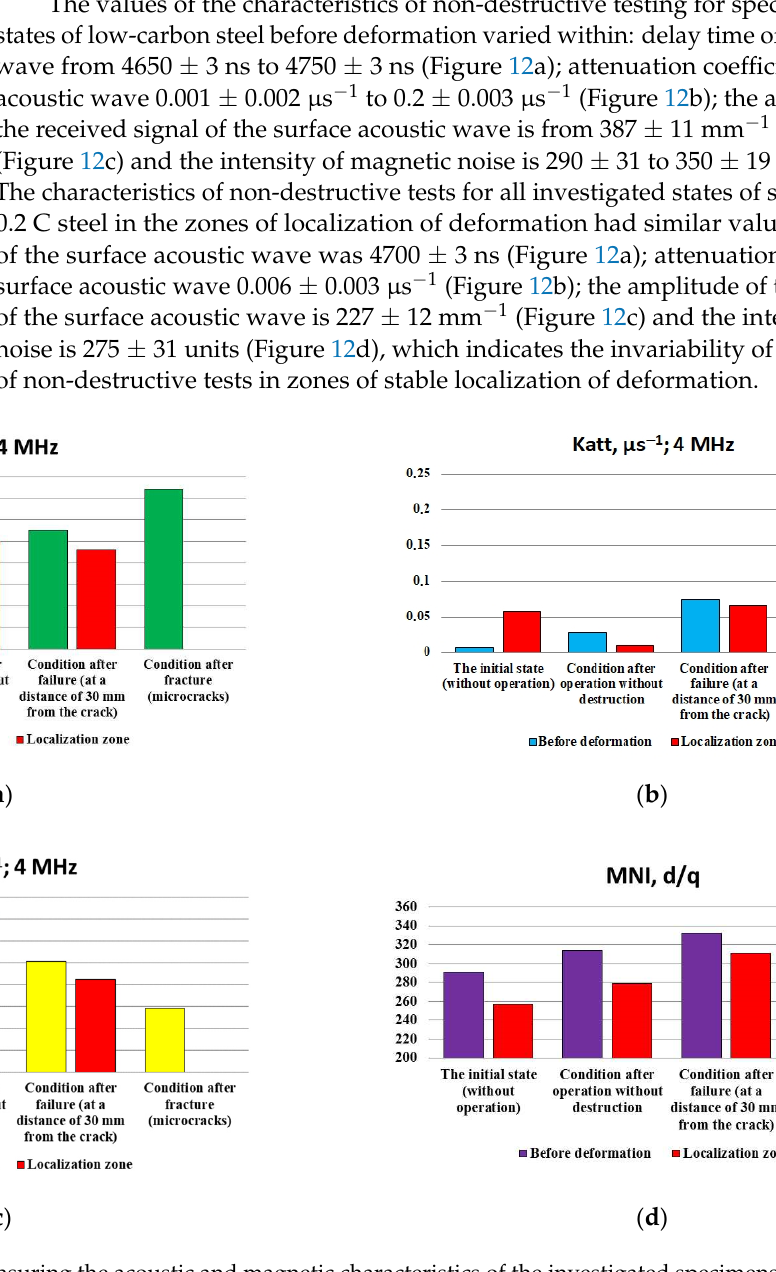
Figure 12 . The results of measuring the acoustic and magnetic characteristics of the investigated specimens of low-carbon steel before deformation and in the zone of localization of deformation: ( a ) is the delay time of the surface acoustic wave (the measurement error of each structural component is ± 2.5%); ( b )—attenuation coefficient of the surface acoustic wave (the measurement error of each structural component is ± 2.5%); ( c )—the amplitude of the received signal of the surface acoustic wave (the measurement error of each structural component is ± 2.5%); ( d )—intensity of magnetic noise (the measurement error of each structural component is ± 3.5%)